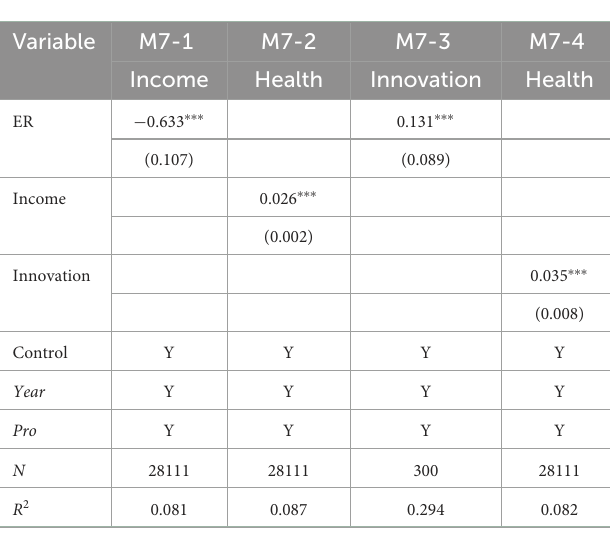
TABLE 7 Mechanism test